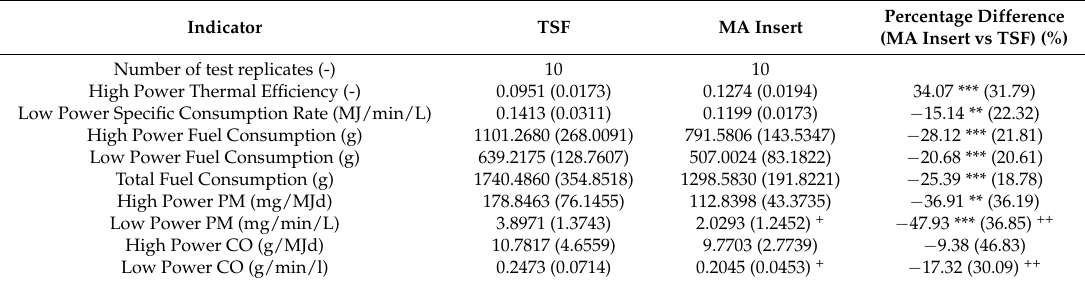
Table 2. Results of laboratory testing for each selected indicator.